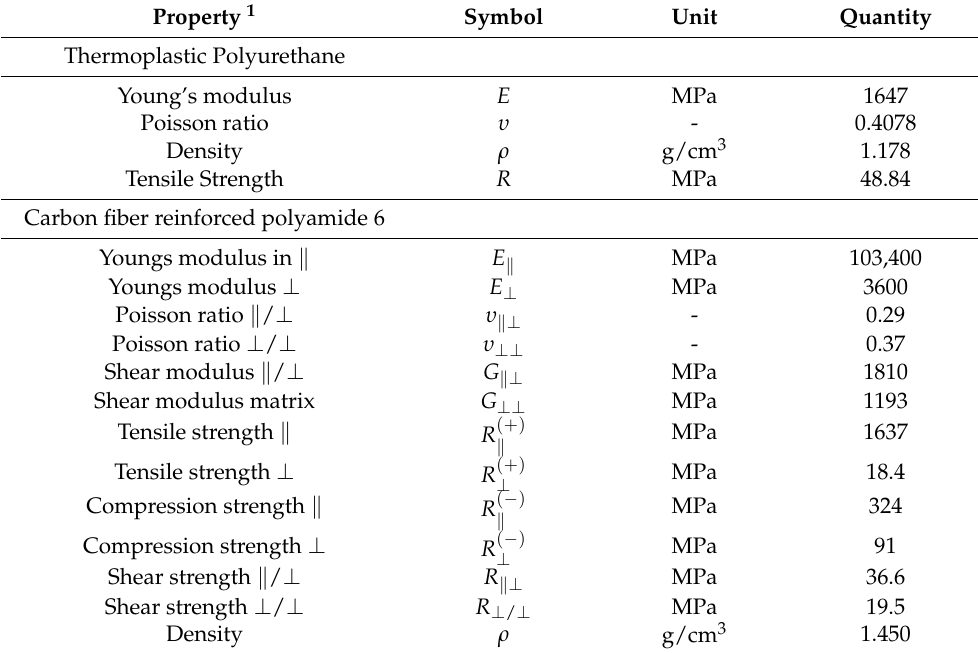
Table 3. Material properties of investigated components [34] (p. 202),